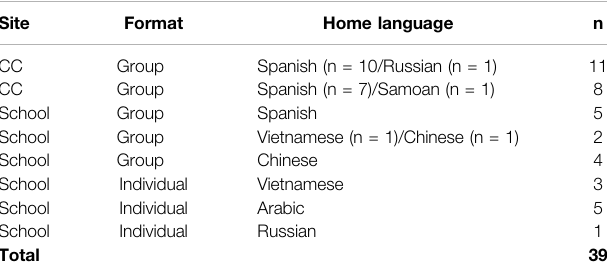
TABLE 1 | Student sample demographics by school site. Bold values are totals.